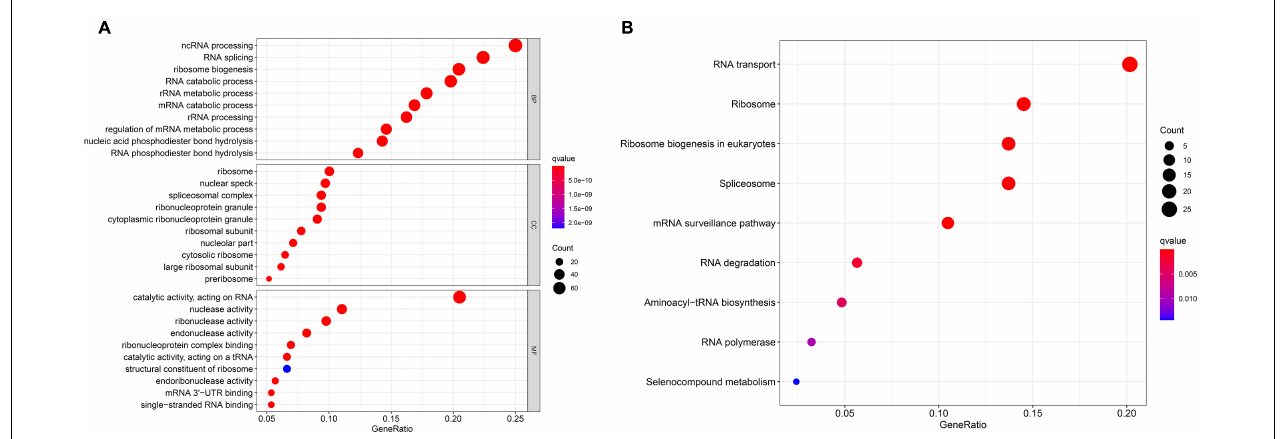
FIGURE 6 | Protein–protein interaction (PPI) network and modules analysis. In the PPI network of differential genes, the matching of 12-RBP signature and core module in LASSO results was demonstrated, among which five core modules contained prognostic gene, and the gray gene represented the matching gene.